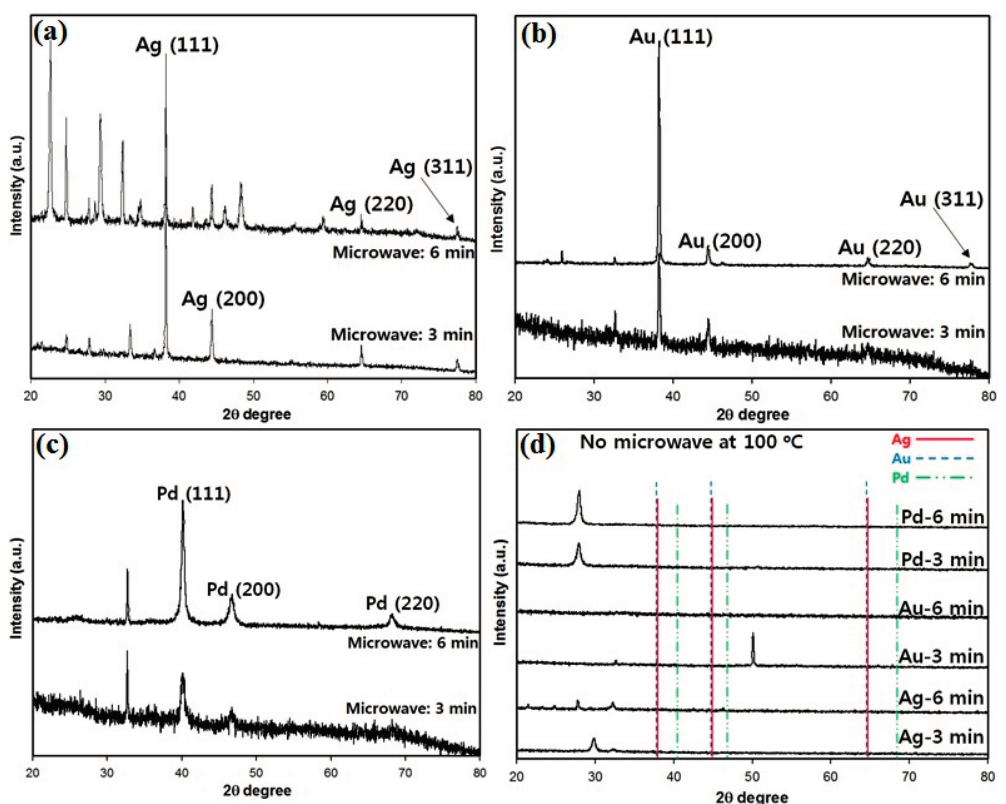
Figure 2. XRD patterns of synthesized samples: ( a ) Ag; ( b ) Au; ( c ) Pd; and ( d ) all samples treated at 100 °C without the MW